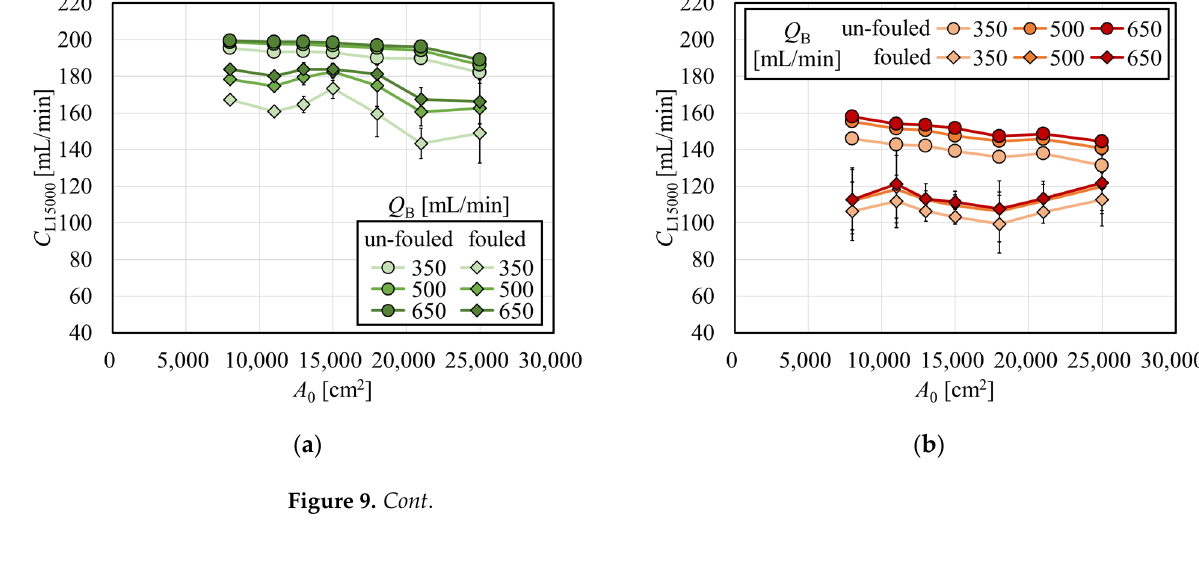
( c ) Figure 9. Clearances normalized to the effective surface area of 15,000 cm 2 ( C L15000 ) as a function of A 0 for ( a ) creatinine, ( b ) vitamin B 12 , and ( c ) inulin. 4. Conclusions By immobilizing albumin on the membrane using glutaraldehyde as a stabilizer, rep- licating the fouling was successfully performed on various modules with different mem- brane surface areas. The modules of various membrane surface areas with and without replication of the fouling were used for the performance evaluation of solute removal. When compared to modules without fouling, creatinine clearance was lower in the modules with fouling; moreover, the smaller the surface area, the larger the fouling effect was observed. In addition, in the APS-SA series with fouling, the clearance decreased slightly with the increase in A 0 in the range of A 0 > 15,000 cm 2 and showed local minima around A 0 = 21,000 cm 2 . It was suggested that unexpected channeling in dialysate due to the high packing density of the hollow fiber may have decreased the mass transfer of cre- atinine. The computation of pressure distribution in modules showed that the change in in- ternal filtration flow rate seemed parallel to that found in the packing density of the hol- low fiber in the APS-SA series. By contrast, the internal filtration flow rate monotonously increased with the increase in membrane surface area in the MFX-S eco series. The design of the module significantly affected the pressure drop in the module and caused a change in the internal filtration flow rate and the solute removal performance.